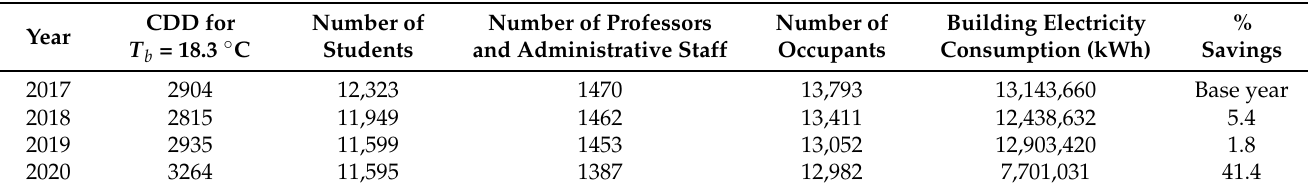
Table 3. Annual cooling needs, building electricity consumption, and number of occupants of ESPOL campus from 2017 to